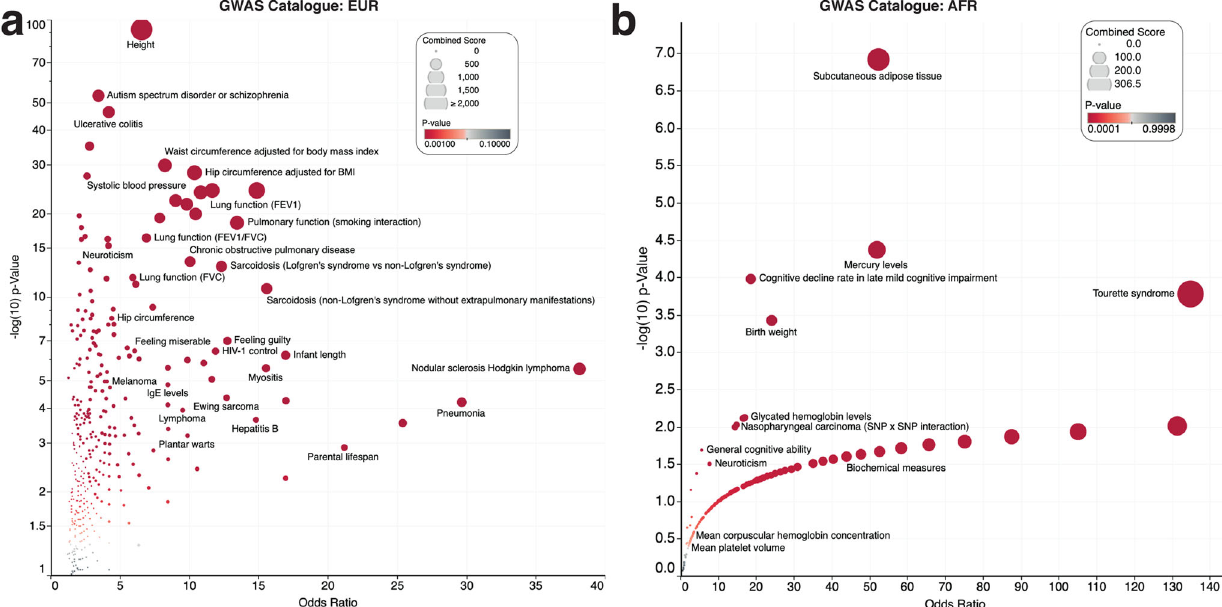
Fig. 3 GWAS catalog enrichment analysis plots. Volcano plots of the GWAS Catalog enrichment analysis for genes where signi fi cant SNPs are located for ( a ) Europeans and ( b ) Africans. All four plots show the adjusted p -value on the y -axis and the odds ratio of the enrichment score on the x -axis. Each circle represents a GWAS Catalog term or Elsevier pathway. The circles are coloured based on the levels of statistical signi fi cance, with the redder colours showing a greater degree of signi fi cance. Each circle is sized based on the combined enrichment score of the term represented by the